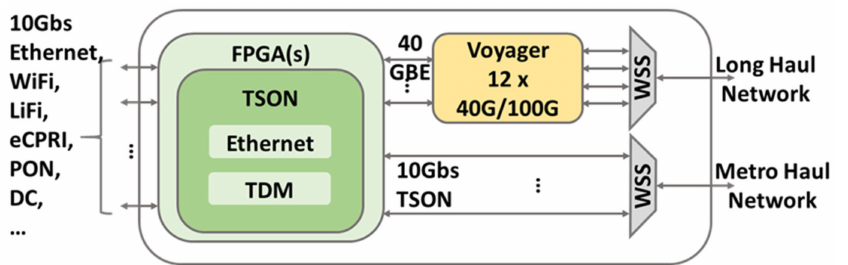
Figure 10. The disaggregated edge node data plane architecture. WiFi: wireless fidelity, LiFi: light fidelity, eCPRI: evolved common public radio interface, PON: passive optical network, DC: data centre, WSS: wavelength selective switches.